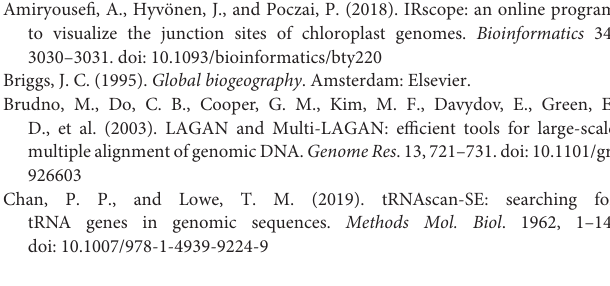
Supplementary Table S1 | List of samples for total DNA extraction and assembly information. Supplementary Table S2 | Nucleotide diversity (Pi) of 18 Goodyera